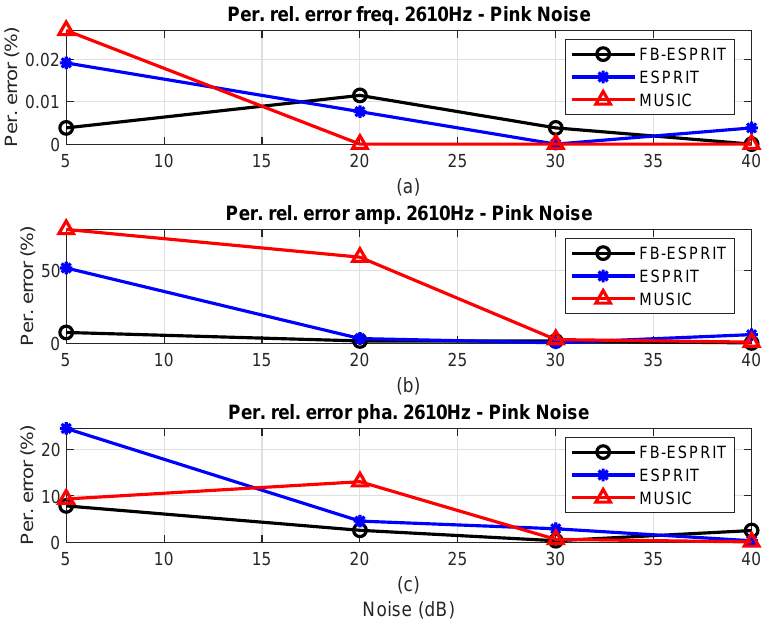
Figure 15. Percentage error (%) of the 2610 Hz component when signal s 2 ( t ) is contaminated with pink noise: ( a ) frequency parameters; ( b ) amplitude parameters; ( c ) phase